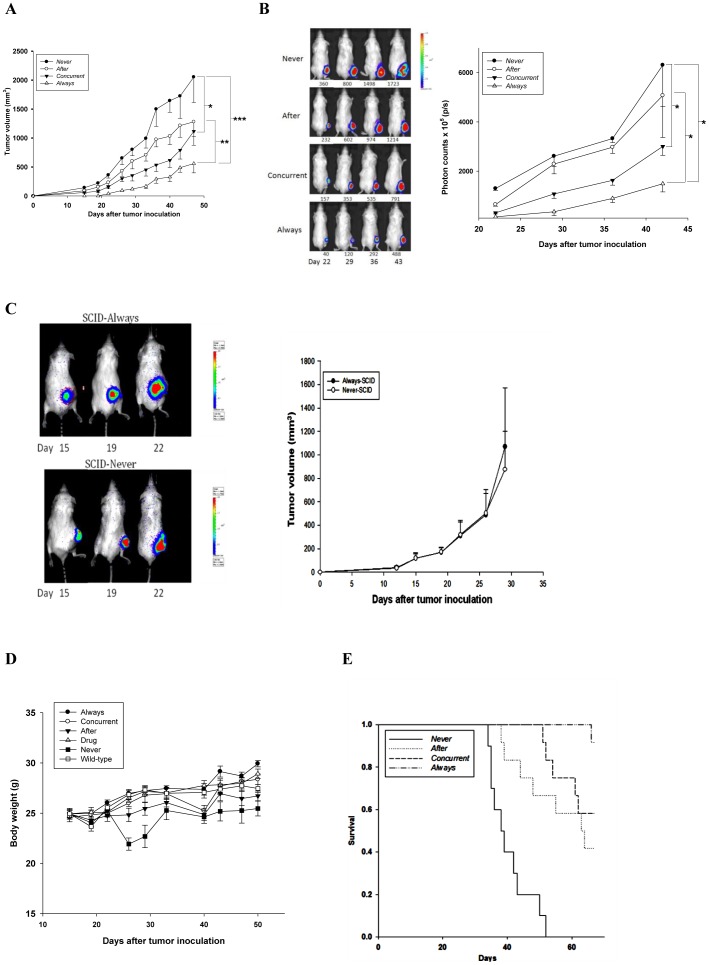
Mirtazapine inhibits tumor growth and prolongs the survival rate and interval in CT-26/luc tumor-bearing model.On day -14, only “Always” mice were inoculated with tumor cells and treated with mirtazapine throughout the experiment, the other three groups were treated with 0.05 ml of 0.9% NaCl plus 0.5% absolute ethanol up to day 0. On day 0, only “concurrent” mice were inoculated with tumor cells and treated with mirtazapine throughout the rest of the experiment, “after” mice were treated with 0.05 ml of 0.9% NaCl plus 0.5% absolute ethanol but without mirtazapine up to day 14, while “never” mice were treated with 0.05 ml of 0.9% NaCl plus 0.5% absolute ethanol and throughout the experiment. On day 14, “after” mice were inoculated with tumor cells and treated with mirtazapine throughout the rest of the experiment. (A) Tumor growth curves are monitored with digital caliper. (B) Left panel: tumor growth curves are monitored with noninvasive bioluminescence imaging (BLI). The value under each mouse is the tumor volume determined with a caliper. Right panel: quantification of the photon counts in ROIs from the left panel. (C) No antitumor effect of mirtazapine was found on immunodeficient SCID mice with CT26/luc tumors. Left panel: tumor growth curves for always and never. Right panel: quantification of the photon counts in ROIs from the left panel. (D) No significant body-weight change (within 20%) through the whole experiment was found among wild-type, drug, never, always, concurrent, and after. (E) Effects of mirtazapine on the survival rate and interval of CT26/luc-bearing mice. The mean survival times are 67, 64, 57, 43 days for always, concurrent, after, and never, respectively. (n = 10 per group, *p<0.05, **p<0.01, ***p<0.001).